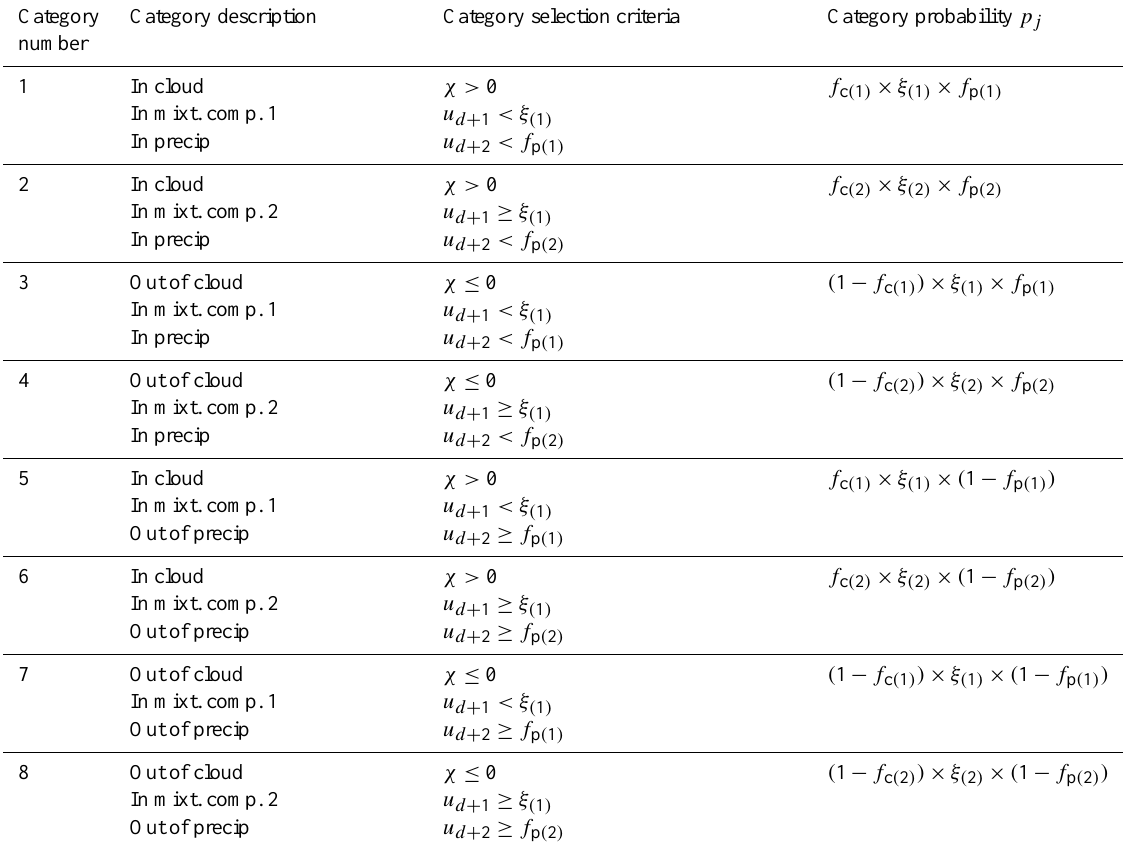
Table 1. For each of the eight categories, this table lists (1) the category number; (2) whether the category is cloudy, in mixture component 1 or 2, or precipitating; (3) what inequalities must be satisfied for a sample point to lie within the category; and (4) the original probability mass associated with the category, p j